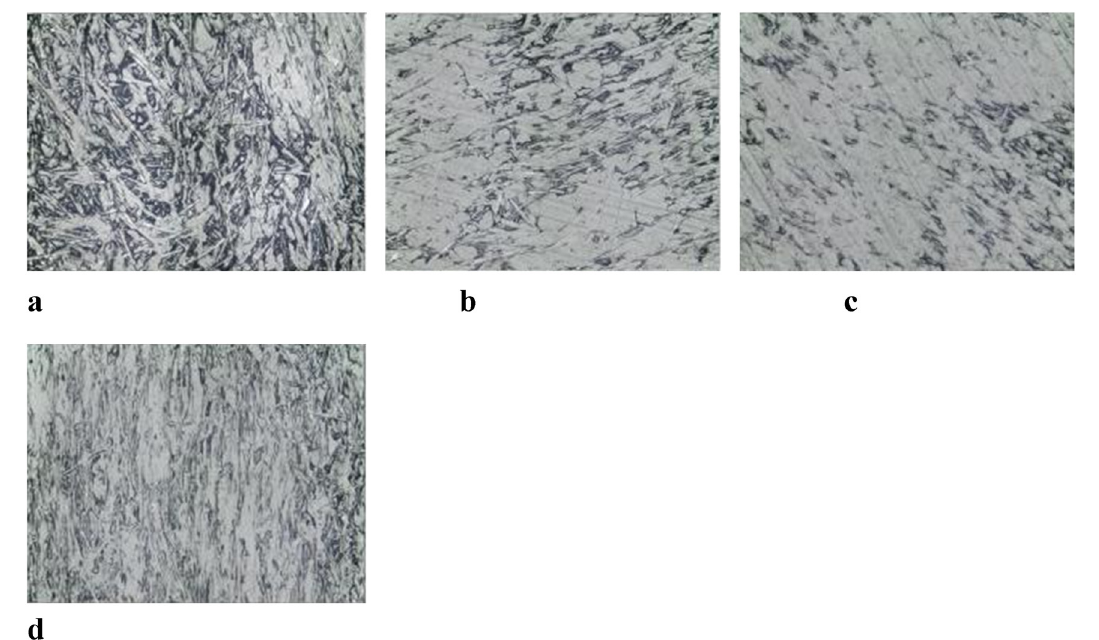
Figure 11: Ultra - deep fi eld microscope photos of H 50 G 50 ( a ) , H 45 T 5 G 50 ( b ) , H 40 T 10 G 50 ( c ) , and H 30 T 20 G 50 ( d ) ,